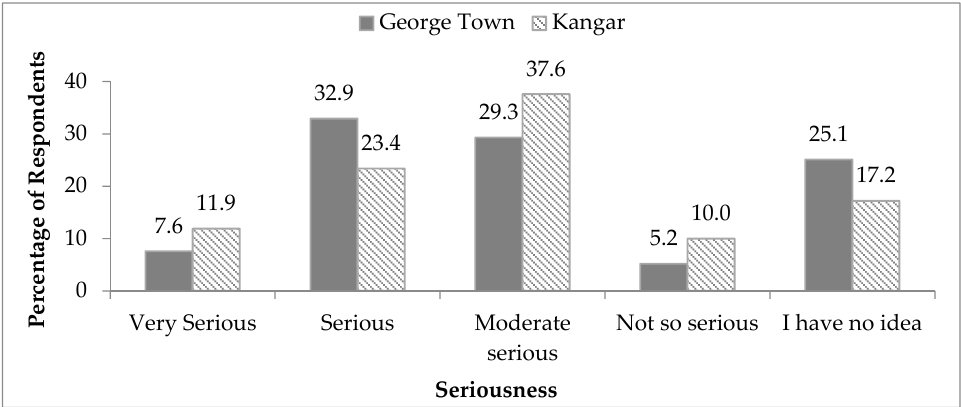
Figure 2. Public perception of the seriousness of water loss issue in Malaysia.